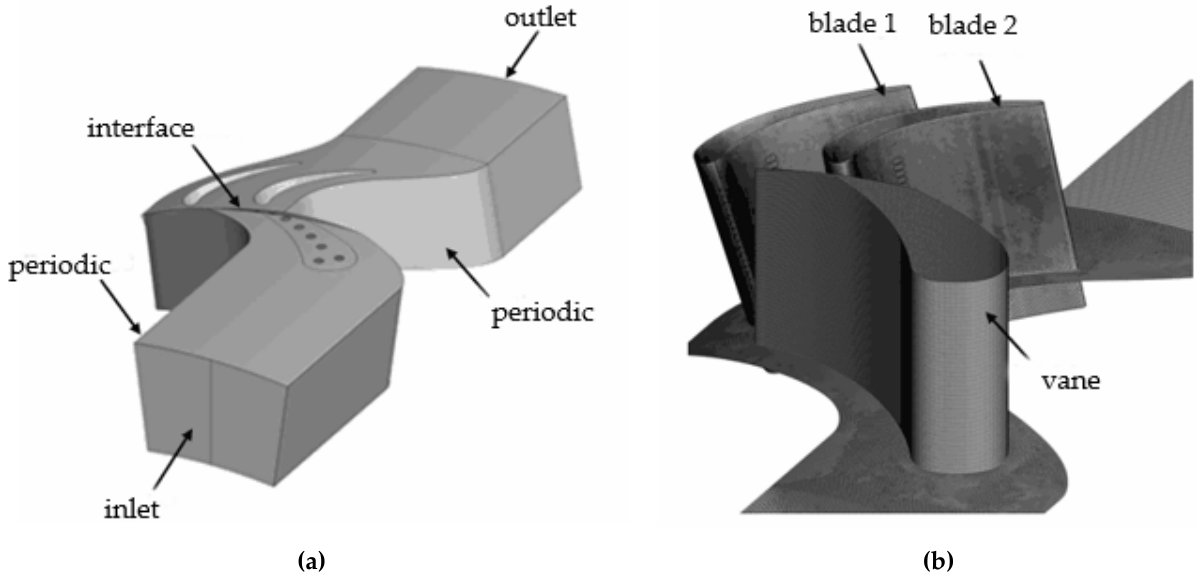
Figure 2. Computational domain and mesh. ( a ) Computational domain; ( b ) mesh. Table 1. Geometric characteristics of cooling channels.